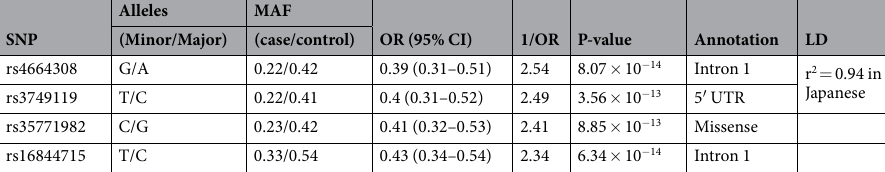
Table 2. The association results of top PLA2R1 SNPs in the combined dataset (222 IMN vs. 701 controls). rs4664308 is the strongest association followed by rs3749119 which is essentially the same signal as the top SNP because of the very high LD. This makes rs35771982 the next strongest association signal.